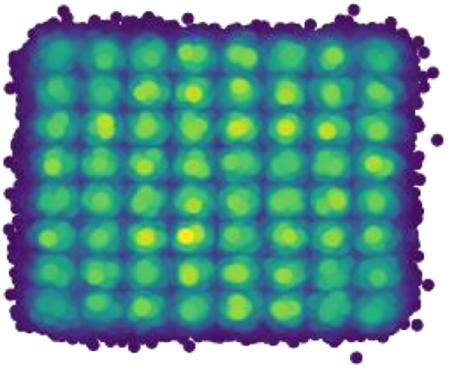
Figure 7: Density distribution of a linearly and nonlinearly distorted 64-QAM showing the highly distorted signal.